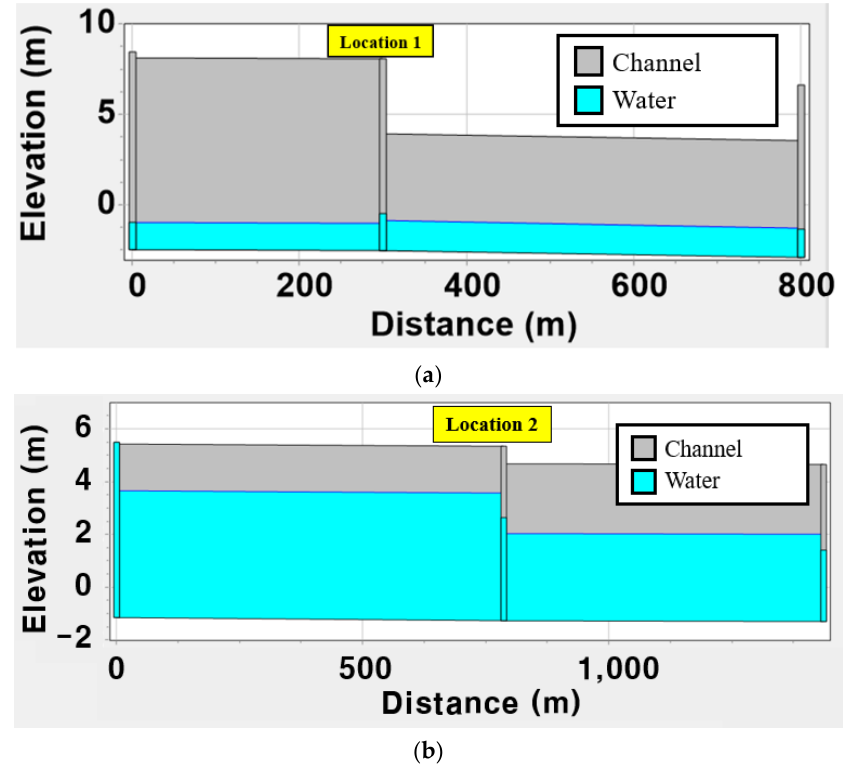
Figure 12. Longitudinal sectional view: ( a ) Location 1; ( b ) Location